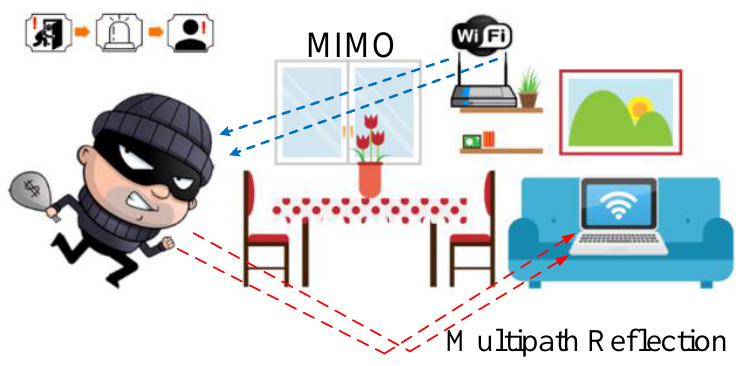
tional sensors or Figure 1. Illustration of detecting indoor intrusion using a commodity Wi-Fi device without addi- tional sensors or cameras.